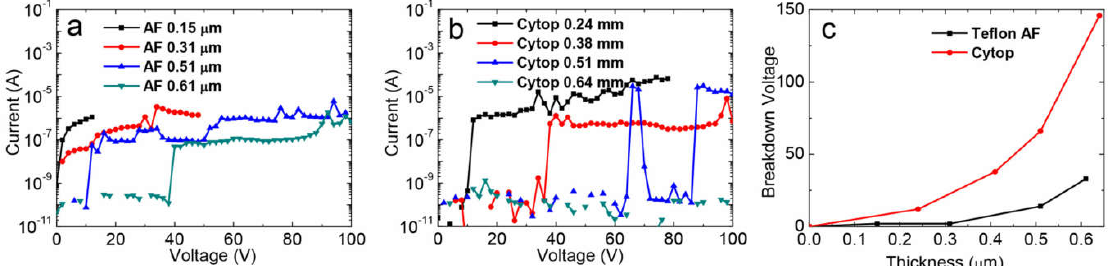
Figure 4. The dependence of leakage current on the voltage of ( a ) Teflon AF coatings, and ( b ) Cytop 809A coatings, of various thicknesses, as well as ( c ) the breakdown voltage of Teflon AF and Cytop 809A, dependent on film thickness.